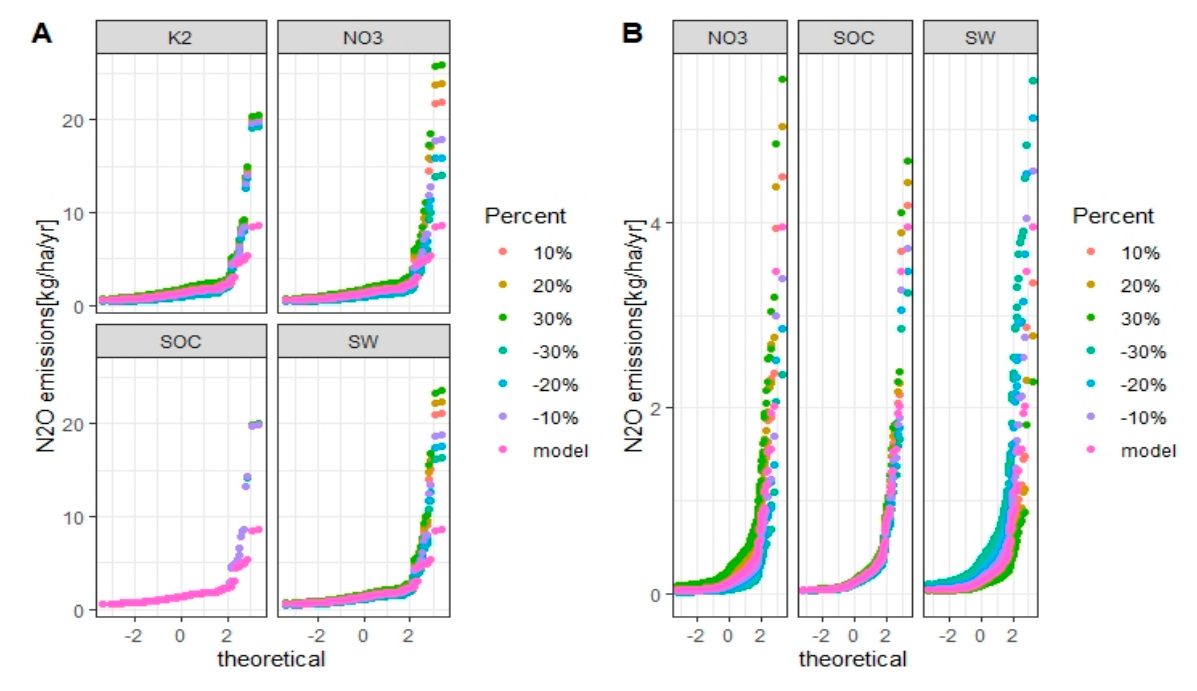
Figure 13. Uncertainties of simulated annual N 2 O emissions from grain corn in the Melk catchment with M1 ( A ) and M2 ( B ) setups for each considered factor. The X-axis is the standard normal distribution of simulated N 2 O emissions with mean 0 and standard deviation 1. Model is the validated SWAT model and is the baseline.